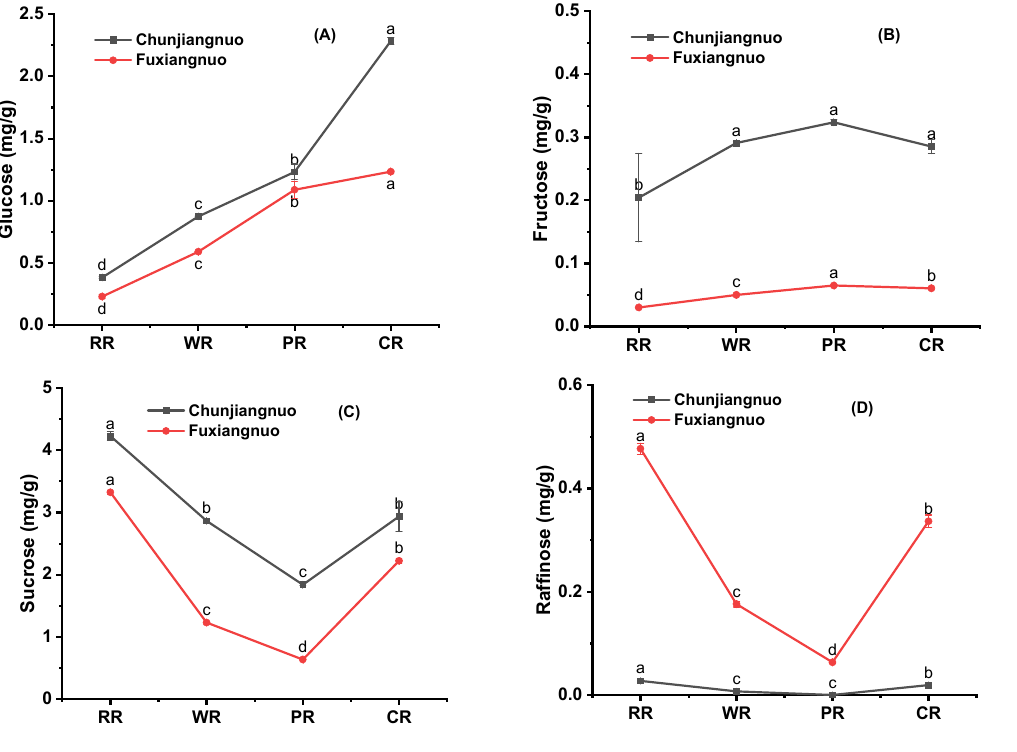
Figure 3. Changes in the soluble sugars during rice cooking process. ( A ): glucose; ( B ): fructose; ( C ): sucrose; ( D ): raffinose. RR: raw rice; WR: washed rice; PR: presoaked rice; CR: cooked rice. Means with the same letter were not significantly different ( p < 0.05).